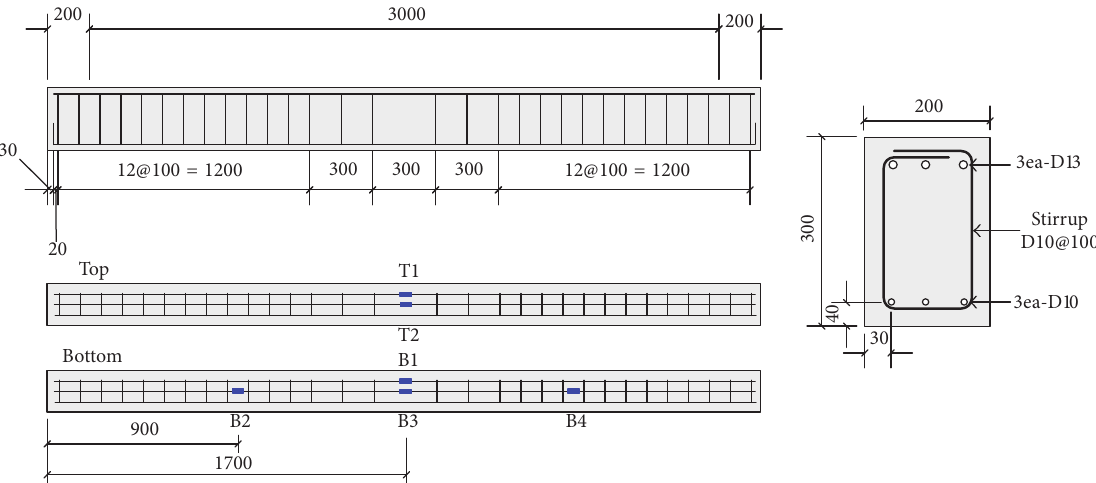
Figure 10: Dimensions and details of specimens [unit: mm].